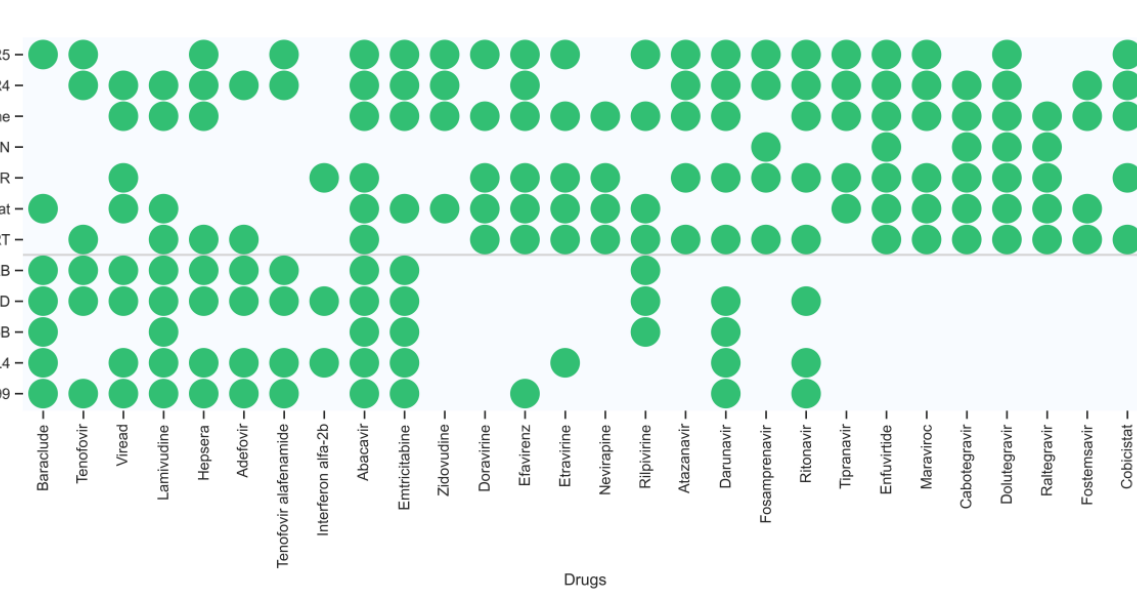
Figure 7. The multitarget distribution of 30 approved drugs identified by our ensemble model.